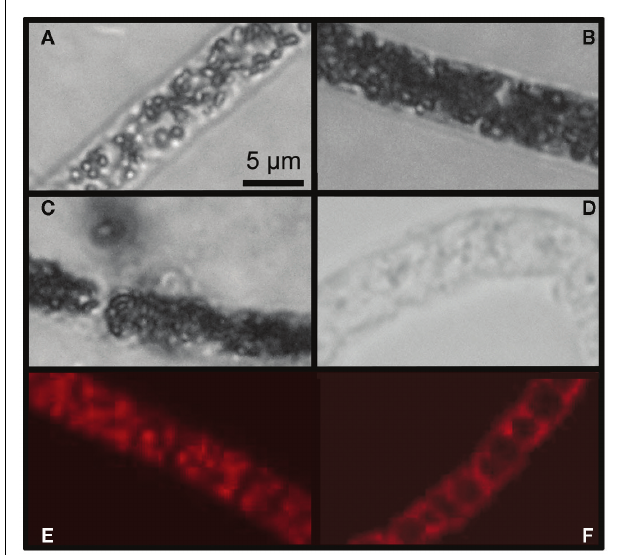
FIGURE 3 | Bright-field and fluorescence micrographs illustrating the typical appearance of Beggiatoa sp. 35Flor filaments cultivated under different conditions. (A+B) Filaments from the mat at the oxygen–sulfide interface of 6-days-old cultures growing under low (A) and high (B) sulfide flux conditions. (C+D) Filaments from cultures grown under high sulfide flux conditions, collected from the mat at the oxygen–sulfide interface after 27days (C) and from the anoxic subpopulation after 12days (D) . (E+F) Nile Red-stained filaments from a 14-day-old culture, collected from the mat at the oxygen–sulfide interface (E) and from the anoxic subpopulation (F) . Bright fluorescence in (E) originates from PHA inclusions, whereas lower fluorescence in (F) is due to staining of the cell membrane